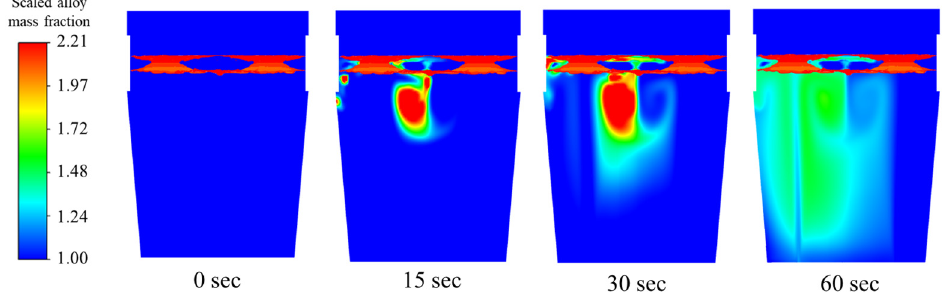
Figure 13. Mixing behavior of copper for 1.70 m 3 /min total flow rate.